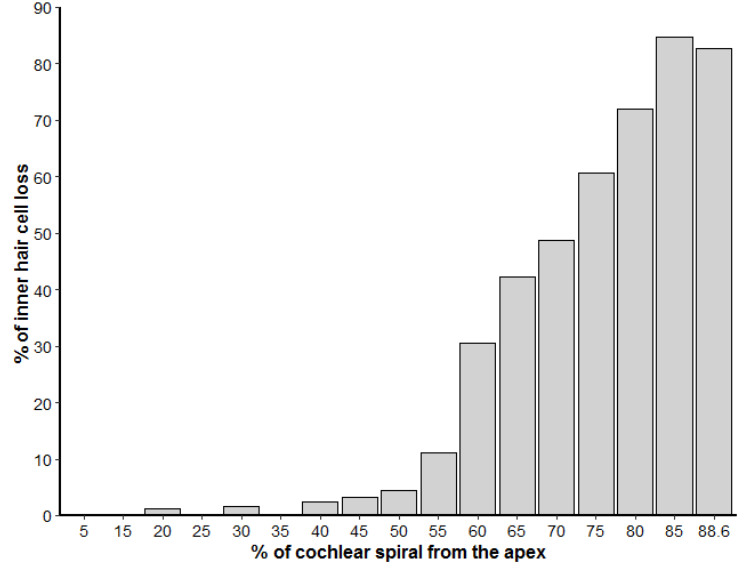
Figure 3. Loss of inner hair cells along the left cochlear spiral, represented in percentage from the apex. The number of inner hair cells was calculated for each 5% increment of the cochlear length.